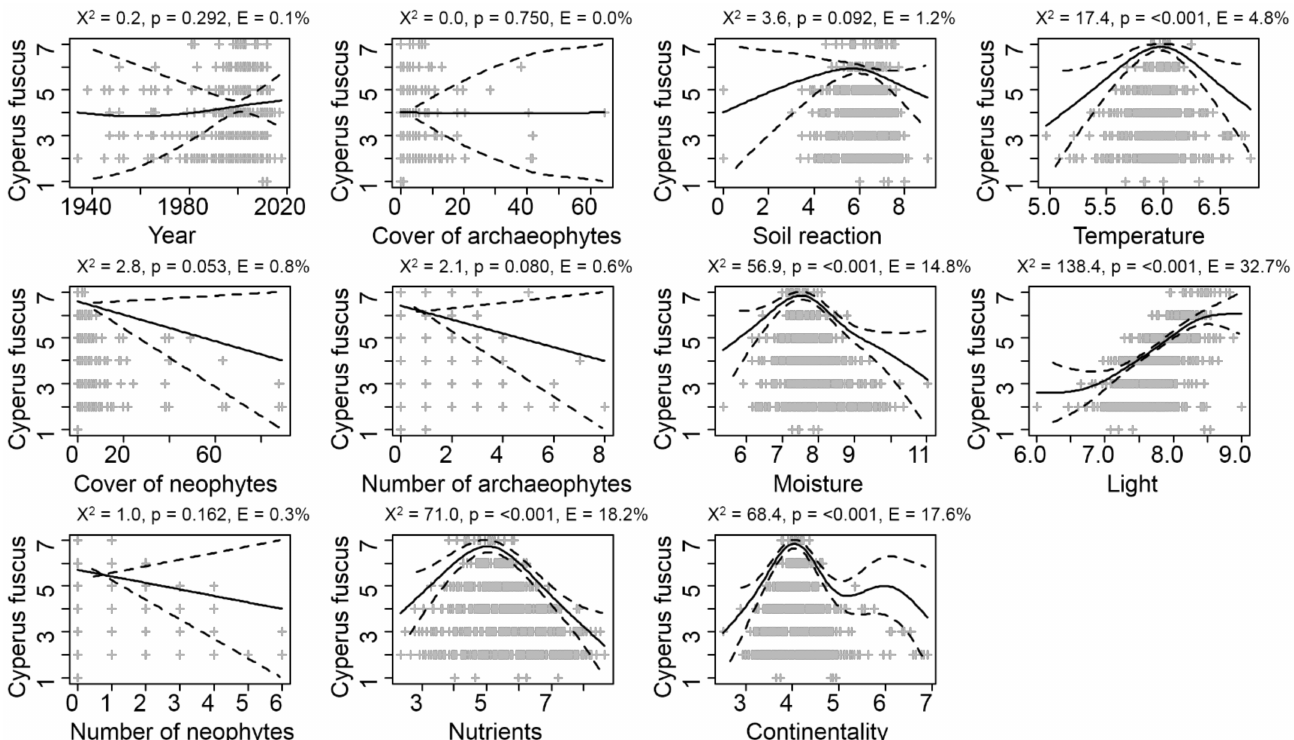
Figure 2. The relationships between the Cyperus fuscus cover in the phytosociological relev é s and selected independent variables fitted by generalized additive models (GAM). The comma-separated values below each subplot denote: the chi-square test statistics of the model, model significance ( p -value), explained deviance (variation).